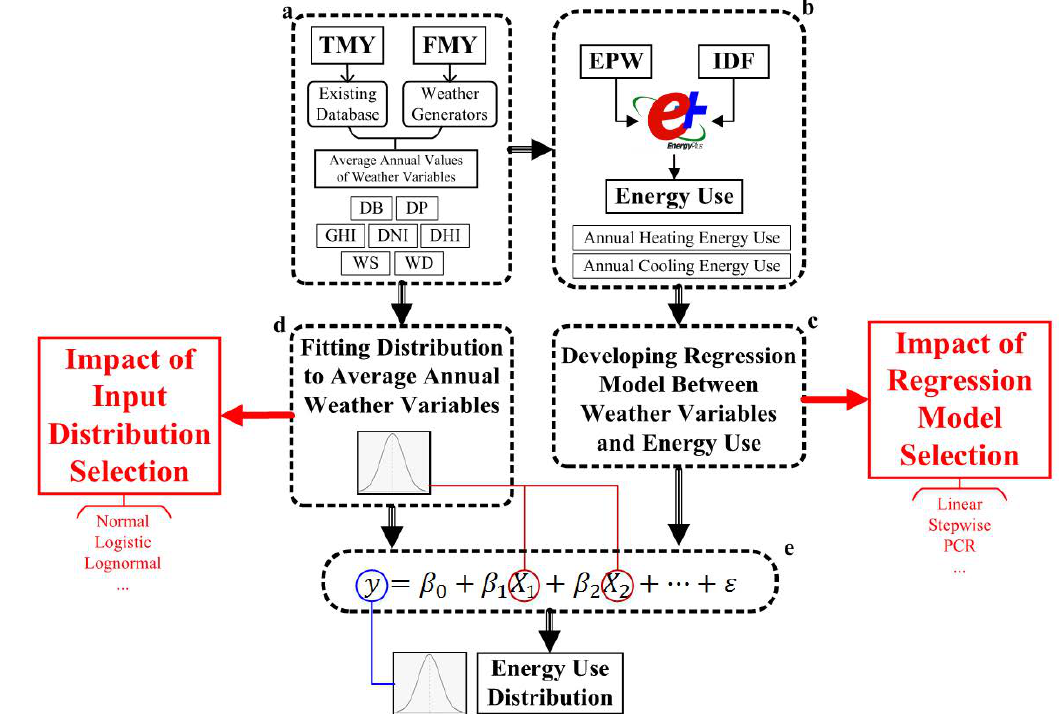
Figure 1. The Four-Step Uncertainty Propagation method followed in the impact assessment (adapted from method proposed by